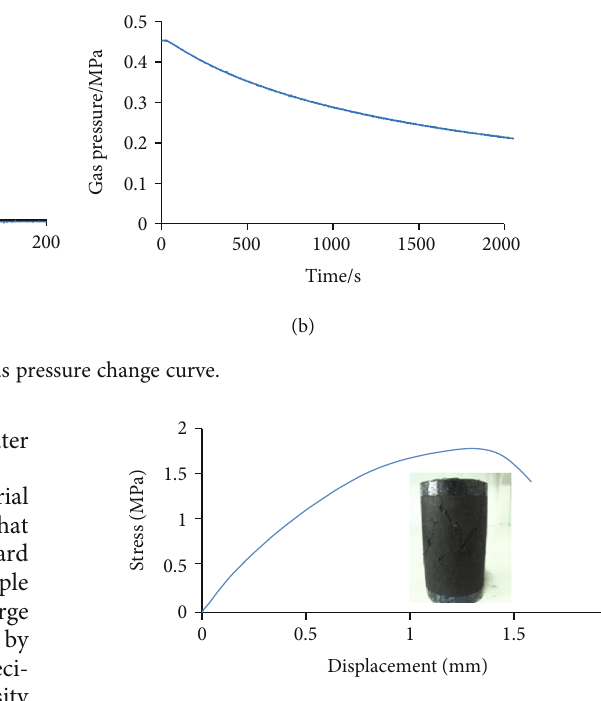
Figure 9: Uniaxial compression curve of similar